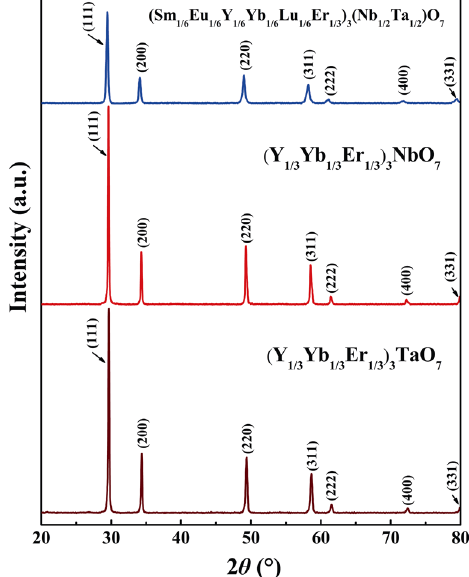
Fig. 2 XRD patterns of the bulk HE RE 3 TaO 7 , RE 3 NbO 7